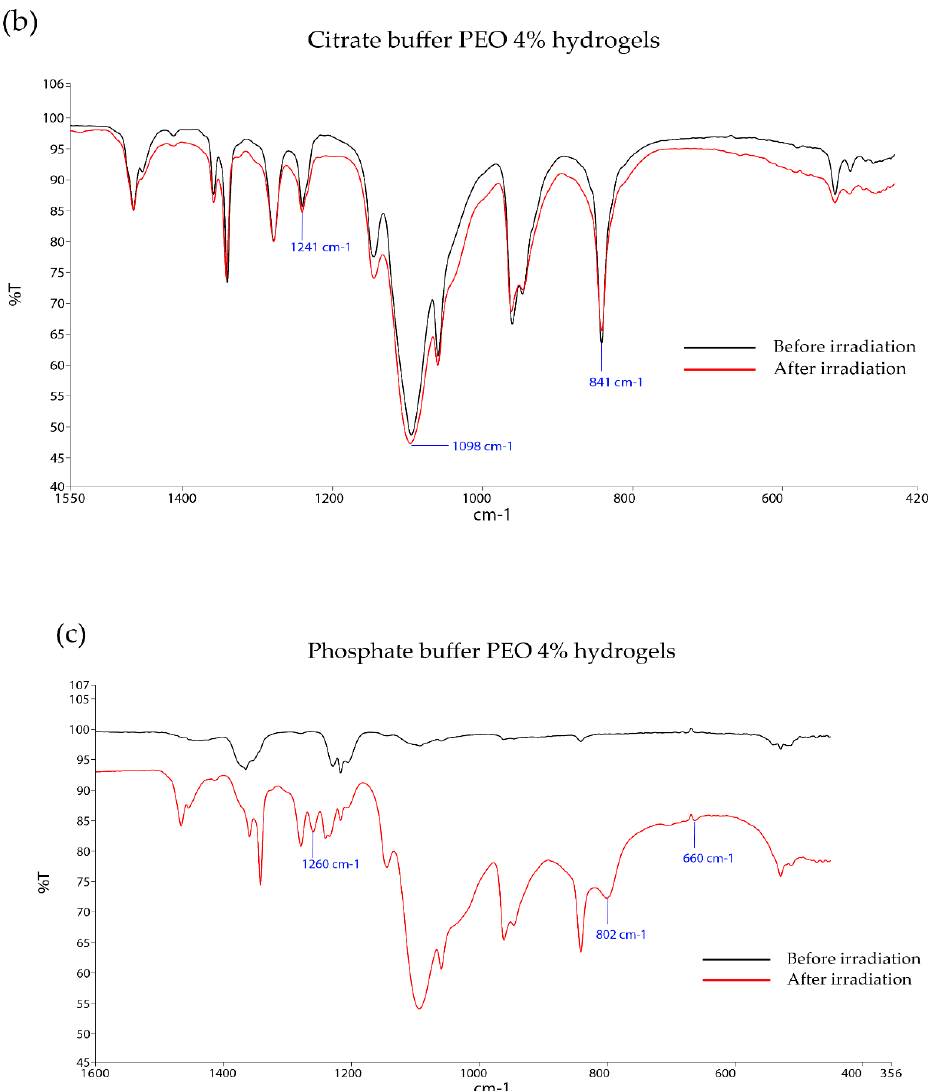
Figure 2. ( a ) Fingerprint region of IR spectra of bi-distilled water PEO 4% hydrogels before and after gamma-ray irradiation; ( b ) Fingerprint region of IR spectra of citrate buffer PEO 4% hydrogels before and after gamma ray irradiation; ( c ) Fingerprint region of IR spectra of phosphate buffer PEO 4% hydrogels before and after gamma-ray irradiation.